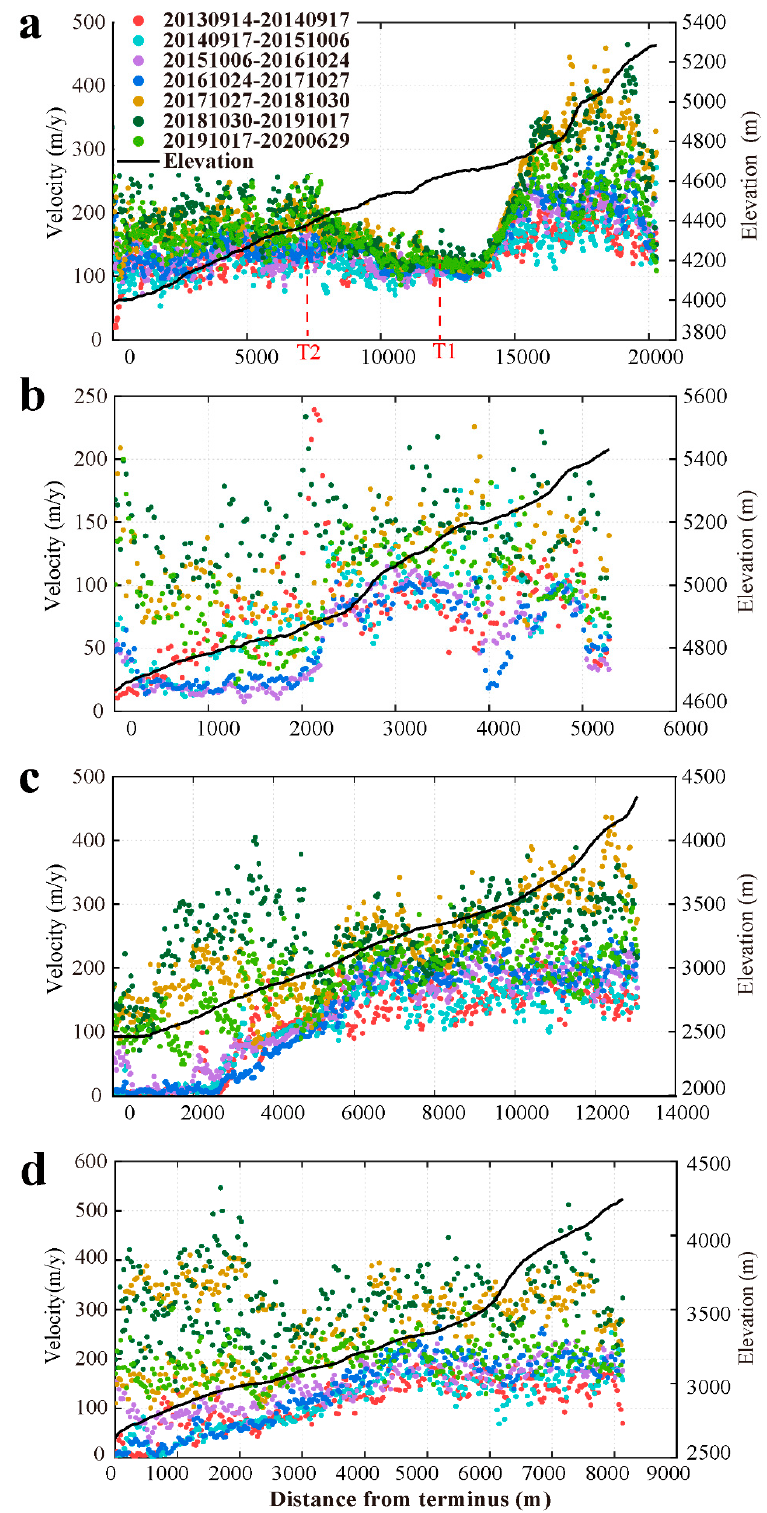
Figure 7. Annual glacier velocity along the centerline from 2013 to 2020: ( a ) Yanong Glacier (GLIMS ID G096657E29334N); ( b ) Parlung No.4 Glacier (GLIMS ID G096920E29228N); ( c ) Azha (GLIMS ID G096818E29132N); and ( d ) Xueyougu Glacier (GLIMS ID G096758E29147N). The gray line indicates the glacier central line elevation. Red dashed lines mark the tributary glacier location.